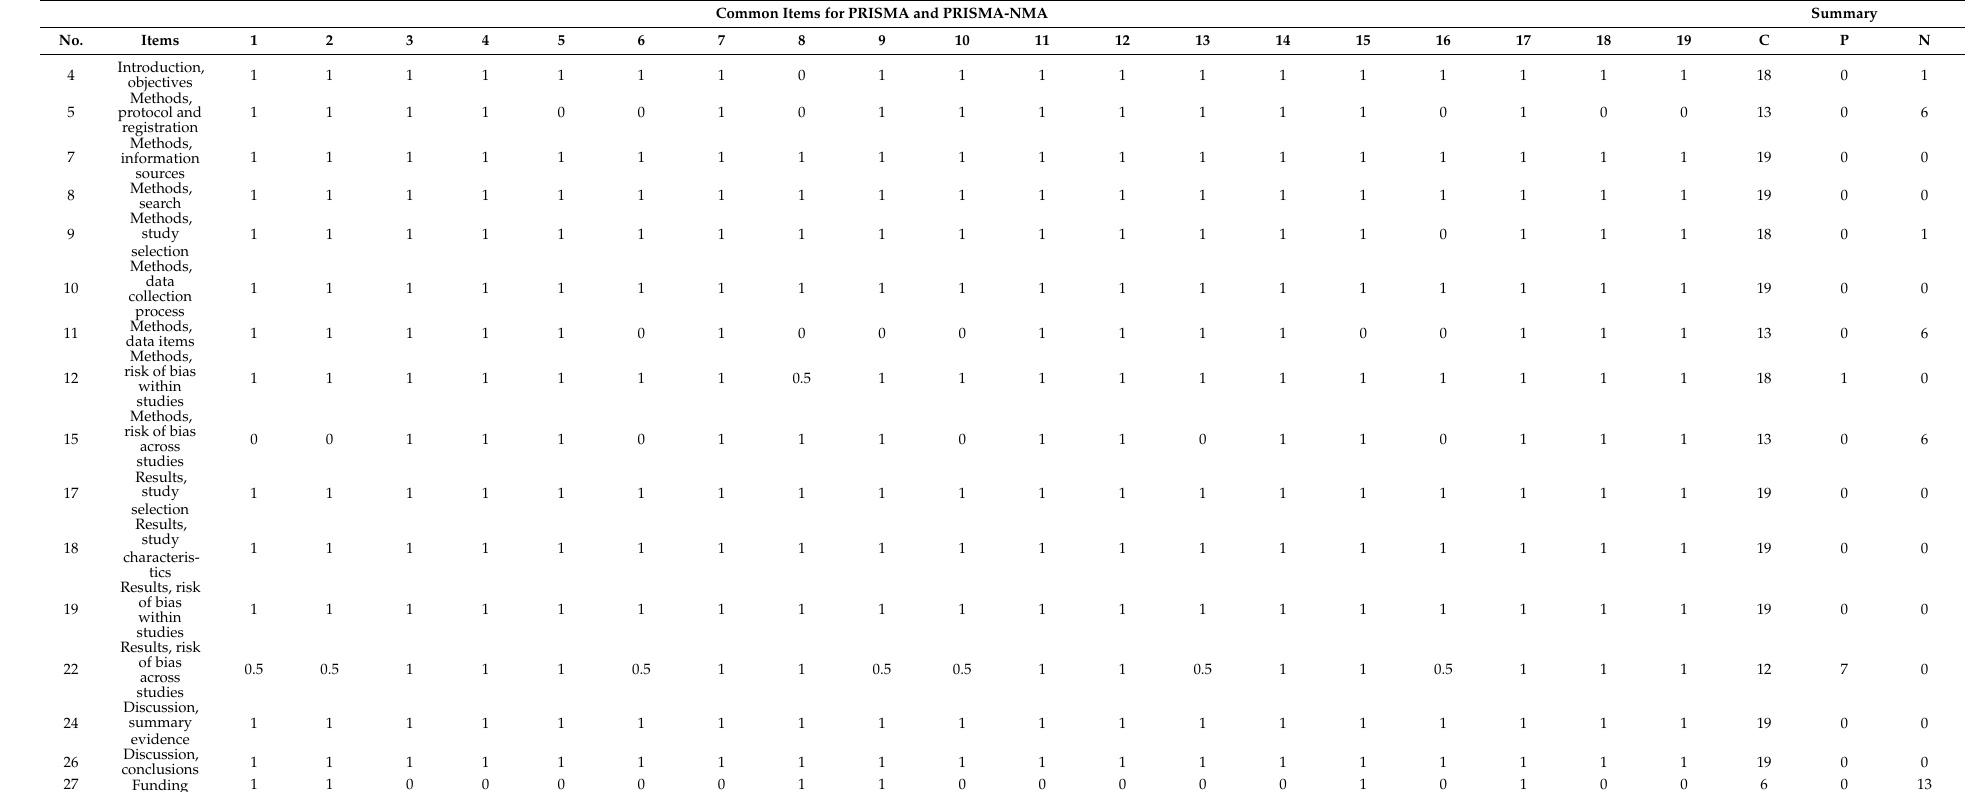
Table 4. Checklist of the reporting standard guideline assessment of the included NMAs.